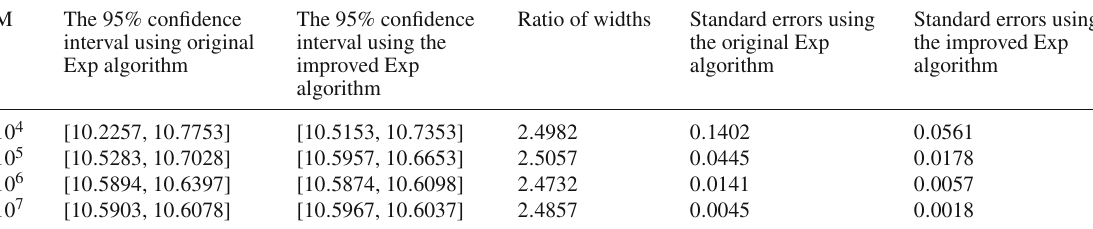
Table 2 95% confidence interval for the down-and-out call barrier option under the CEV model with β = − 0 . 5, σ = 0 . 25 and (cid:7) t = E [ δ t ] = 0 . 002 M The 95% confidence interval using original Exp algorithm